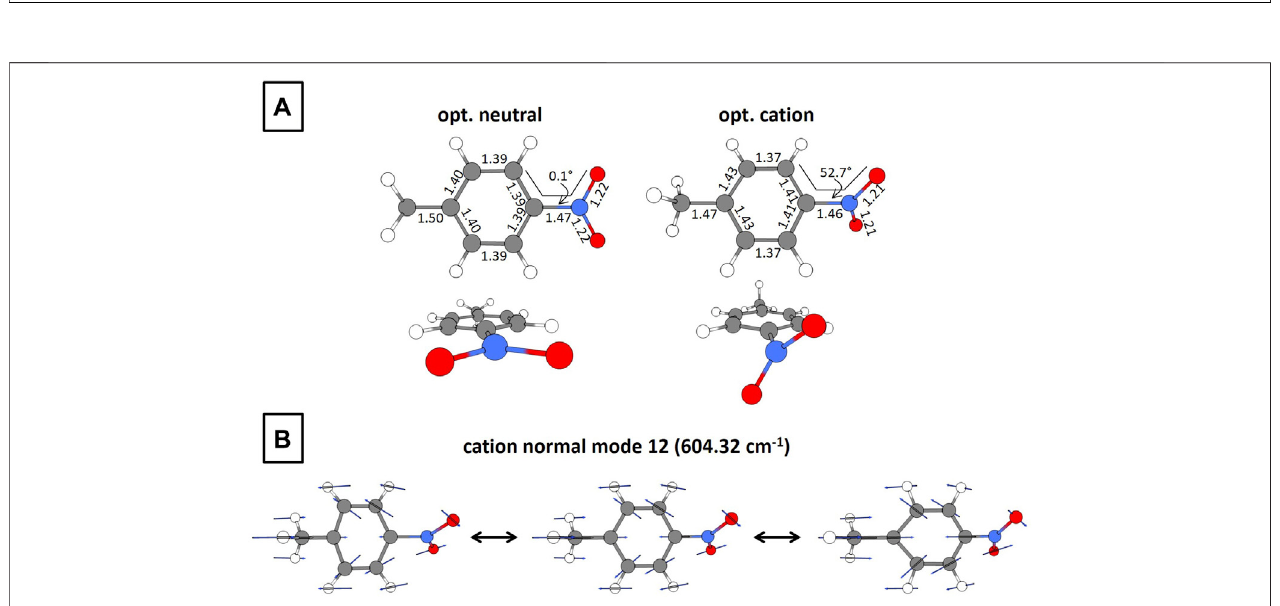
FIGURE 3 | (A) Geometrical structures for optimized neutral and cationic PNT. Bond lengths are in Å and torsional angles in degrees. (B) Normal mode at 604.32 cm − 1 for the optimized PNT cation. The calculations were performed at the B3LYP/def2-TZVPP level of theory.